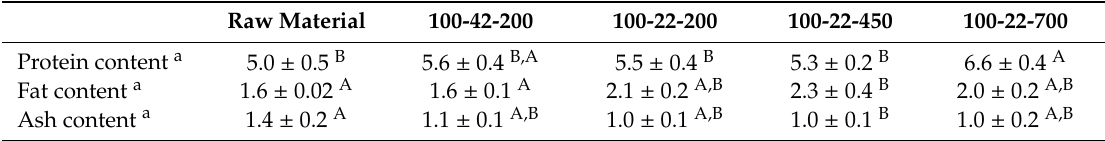
Table A2. Protein, fat, and ash contents (g / 100 g dry matter) of raw and extruded apple pomace (mean value ± standard deviation, n = 3).